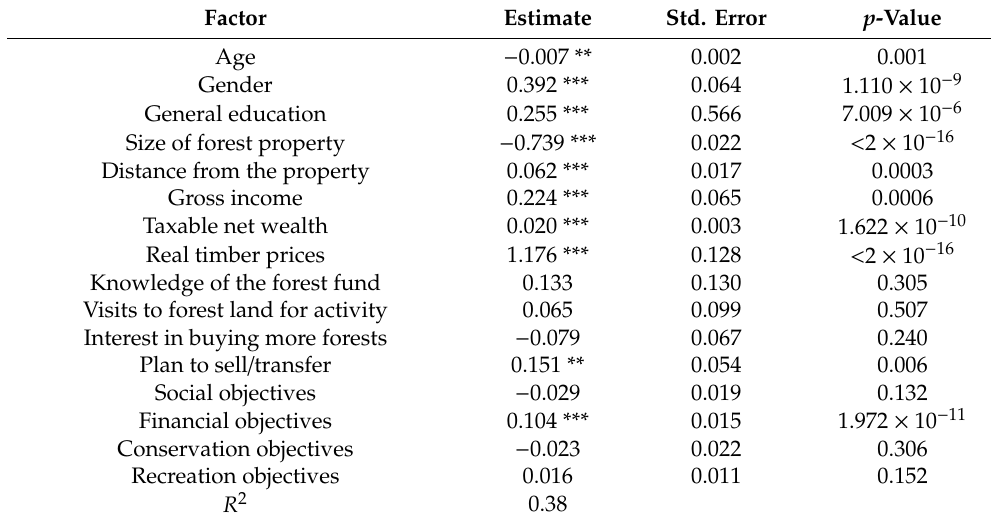
Table 4. Parameter estimates of the linear model in the period 2003–2012 ( N = 2682) (Dependent variable: m 3 ha − 1